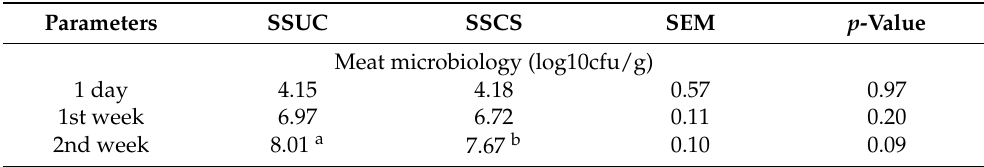
Table 4. Effect of slaughtering with or without state of consciousness on Longissimus dorsi muscle’s microbiology in Korean Hanwoo Finishing Cattle during storage at 4 ◦